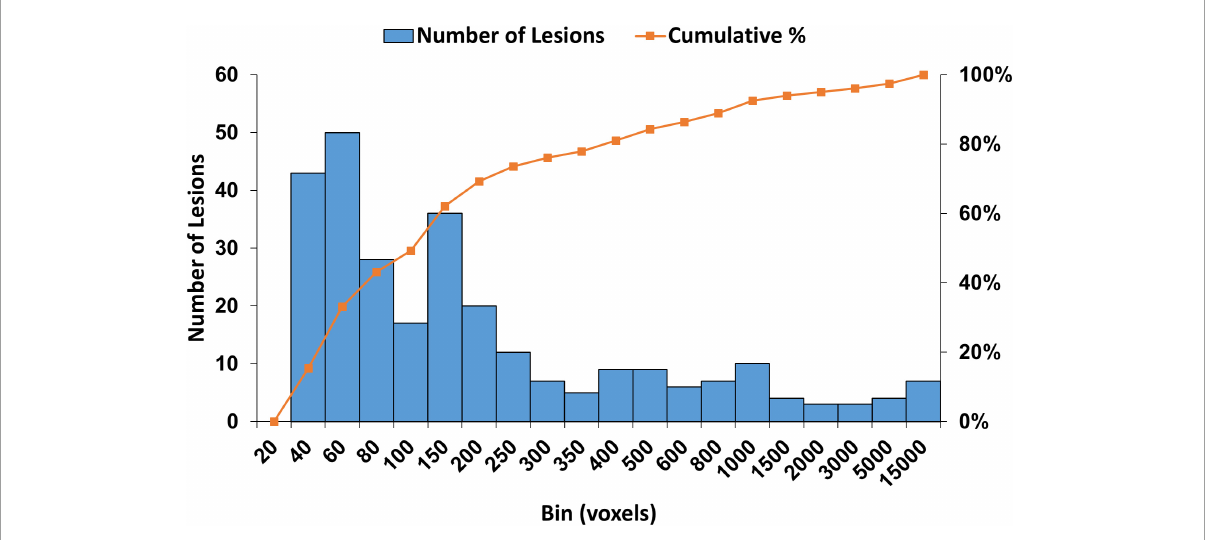
FIGURE2 The histogram of WMH3D lesion size distribution for all subjects. The cumulative lesion size distribution is shown in percentage on the right vertical